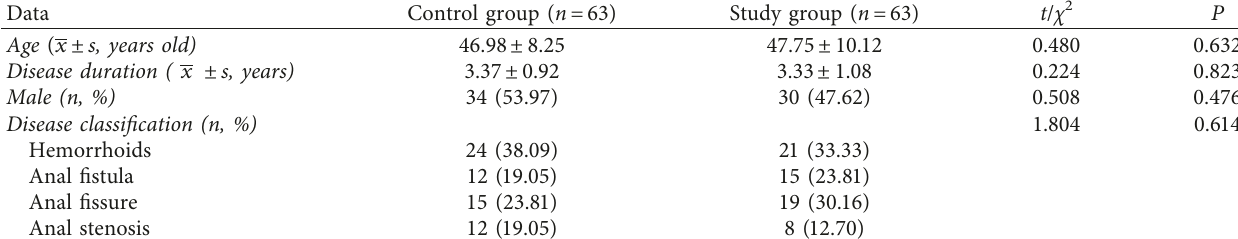
Table 1: Baseline data for both